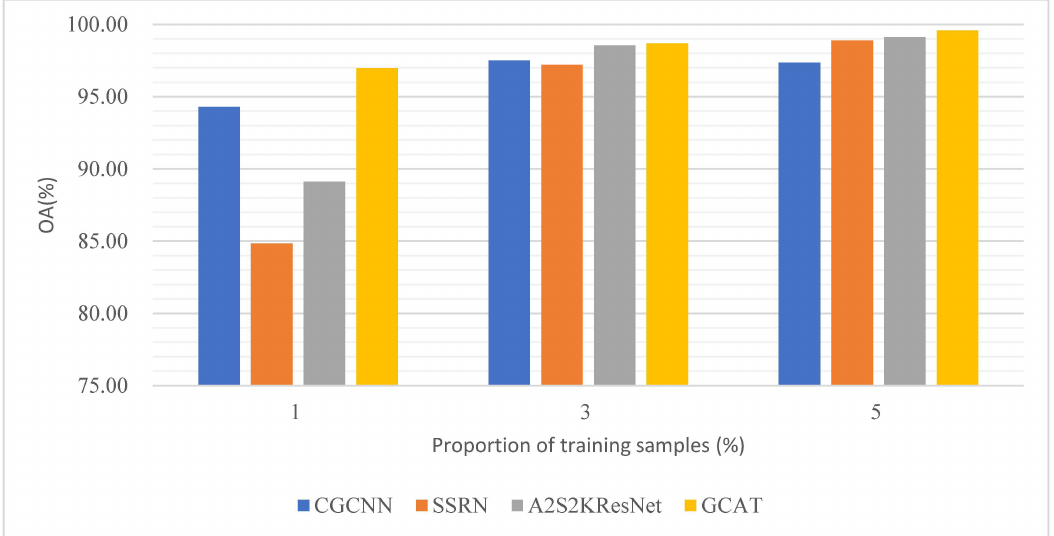
Figure 7. Classification results on the oil film thickness data with different proportions of training